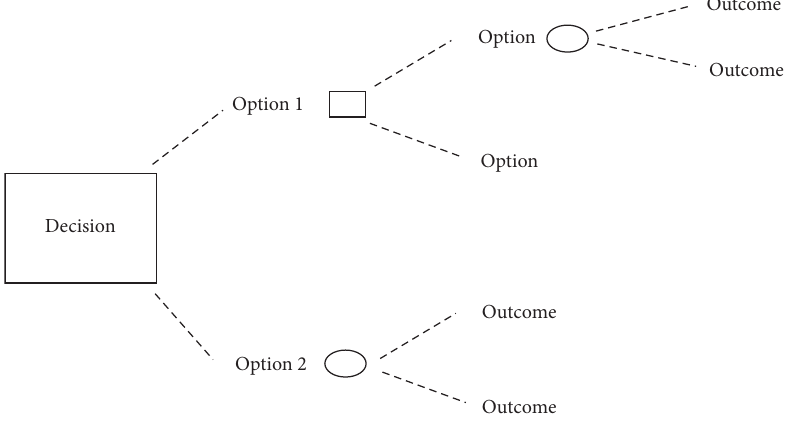
Figure 5: Representation of decision